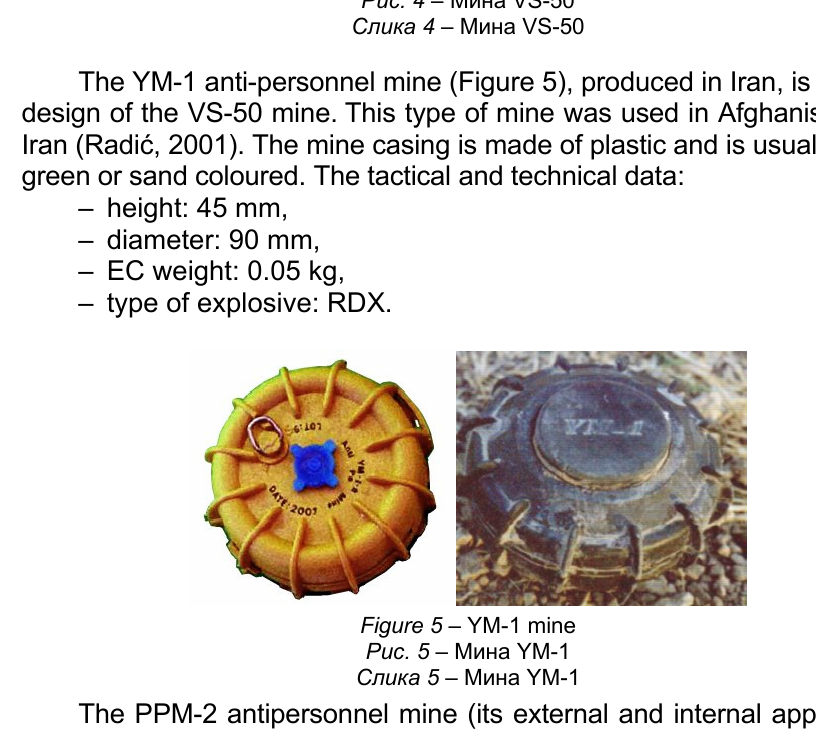
Figure 4 – VS-50 mine Рис . 4 – Мина VS-50 Слика 4 – Мина VS-50